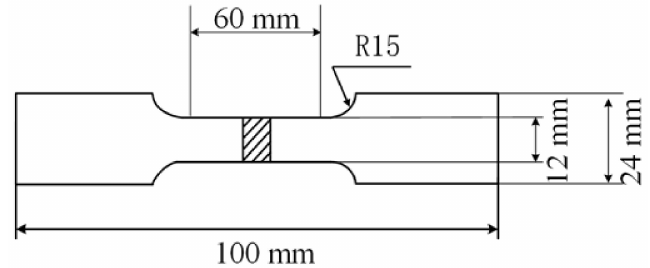
Figure 10. Dimensions of tensile strength test